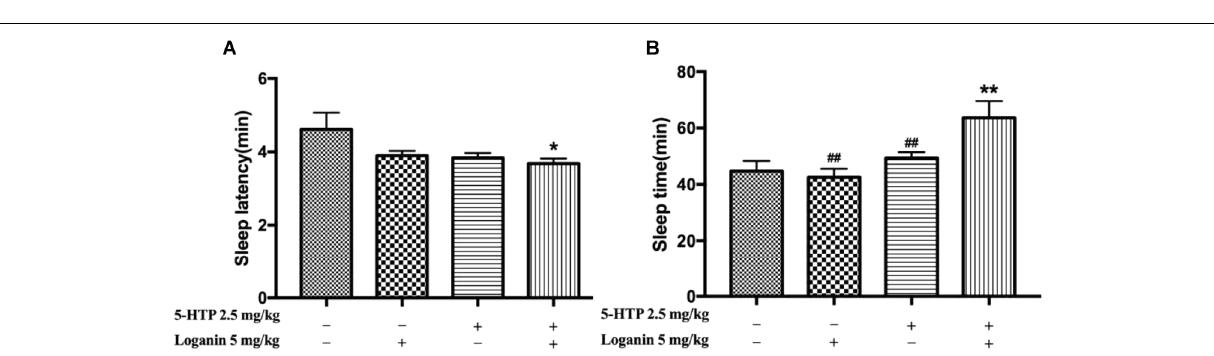
FIGURE 7 | Synergic effects of loganin with 5-HTP on sleep in pentobarbital-treated mice. The sleep latency (A) and sleep time (B) were assessed. Data are presented as mean ± SEM ( n = 12). ∗ P < 0.05, ∗∗ P < 0.01, vs. vehicle (Student-Newman-Keuls test); ## P < 0.01, vs. group treated loganin and 5-HTP (unpaired Student’s t -test).